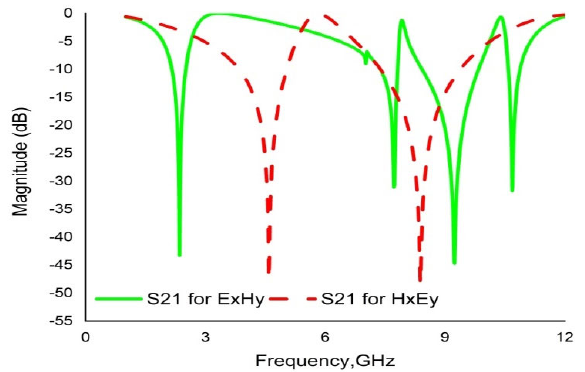
Figure 7. Transmission coefficient ( 𝑺 𝟐𝟏 ) with interchanging field propagation.